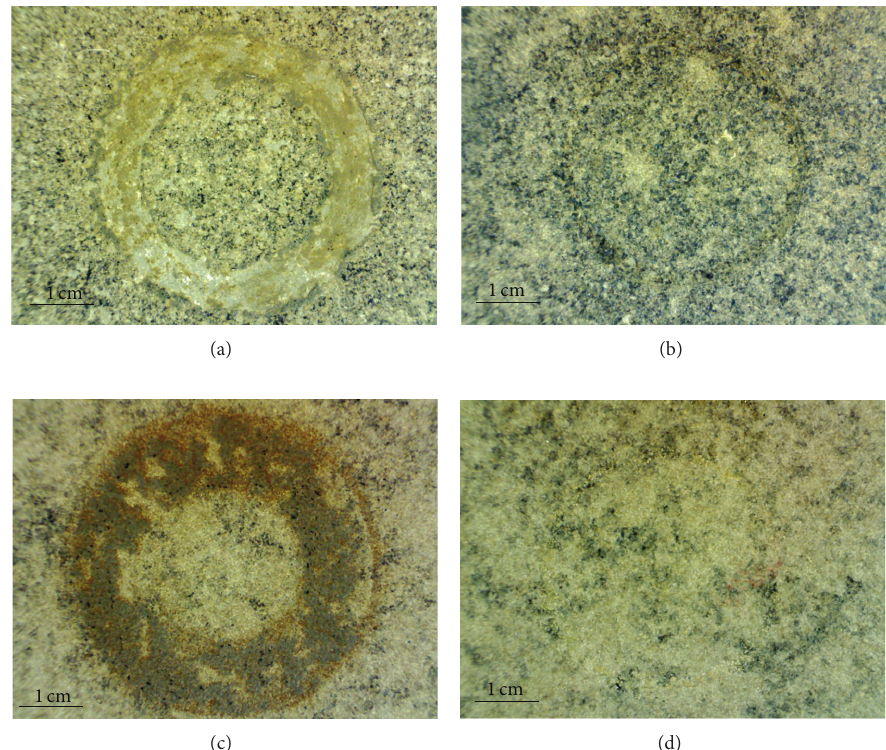
Figure 5: Optical micrographs of the four coating surfaces (a) S1 at 20 𝜇 m thickness, (b) S1 at 30 𝜇 m thickness, (c) S2 at 20 𝜇 m thickness, and (d) S2 at 30 𝜇 m thickness.